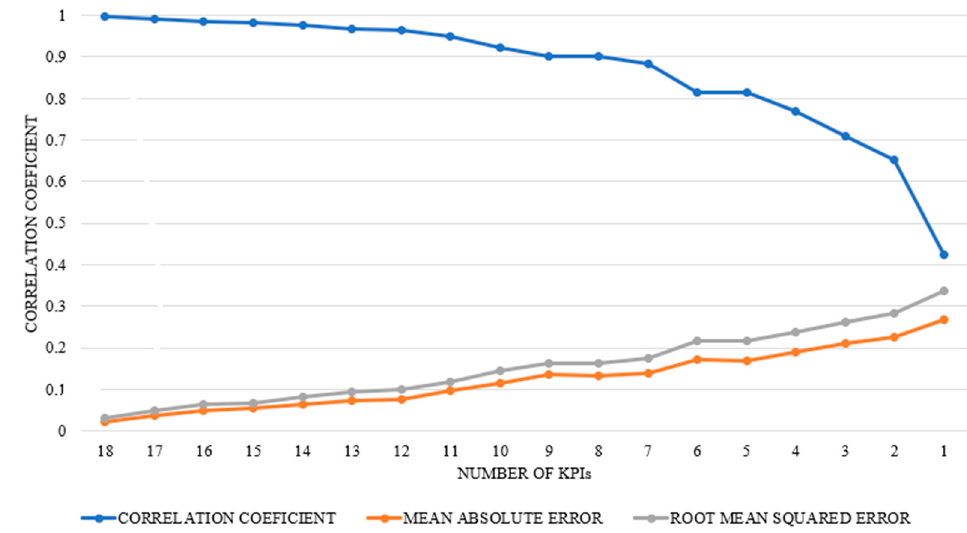
Figure 5. Progression of correlation coefficient and error levels.